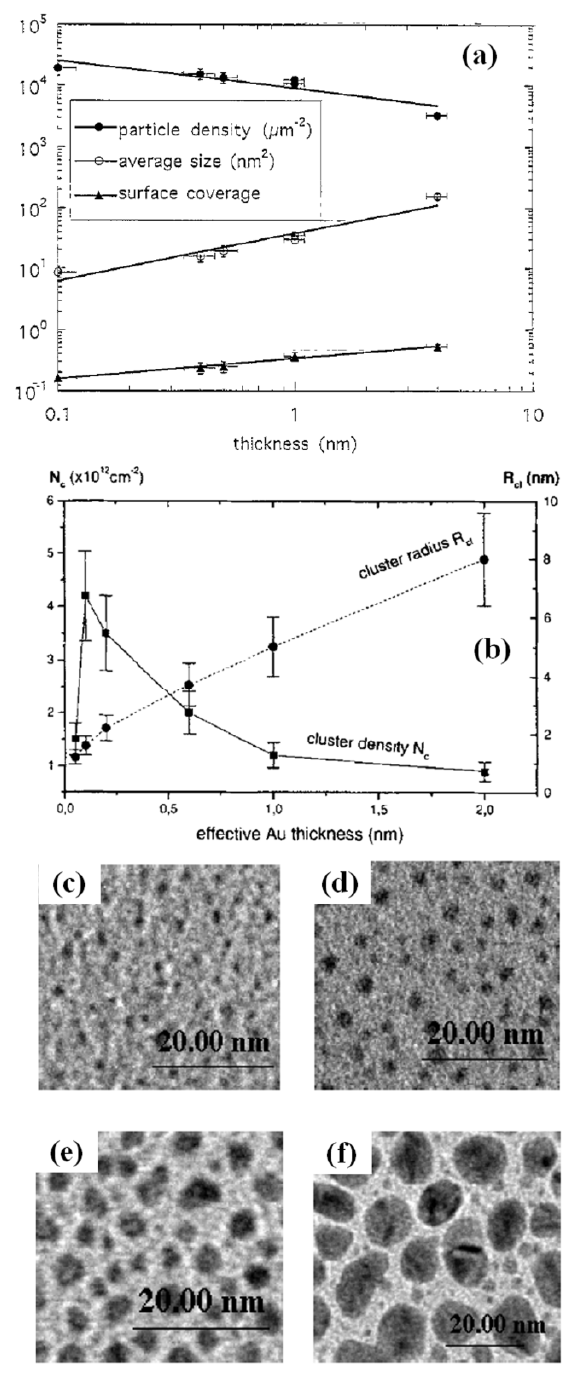
Figure 4. ( a ) Average area, surface density and surface coverage evolution (as a function of the film thickness h) for Au particles formed on polystyrene surface by room temperature Au evaporation. ( b ) Density and radius versus effective thickness, for NPs obtained by Au evaporation (at room temperature) onto polyimide. ( c – f ) TEM images corresponding to Au deposited at different thicknesses onto polyimide at a rate of 0.1 nm/min at room temperature: 0.1 nm ( c ), 0.2 nm ( d ), 0.6 nm ( e ), and 2.4 nm ( f ). ((a): reproduced with permission from [26], Copyright Elsevier 1997; (b): reproduced with permission from [30], Copyright AIP Publishing LLC 1999; (c–f): reproduced with permission from [31], Copyright Taylor & Francis